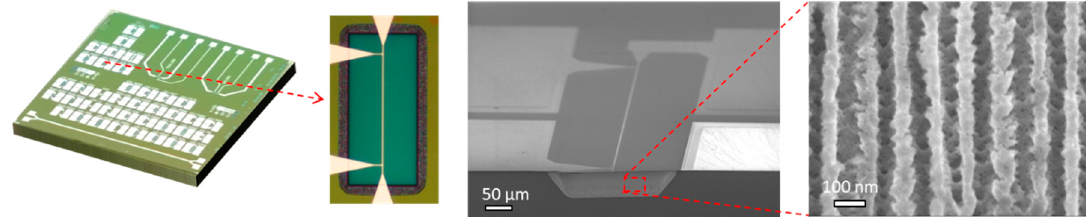
Figure 2. Single chip with different heater/sensor areas ( a ), individual Al heater/sensor (200 µm × 2 µm) with PS layer under it ( b ), cross-sectional SEM of PS well ( c ), and high-resolution SEM of PS layer ( d